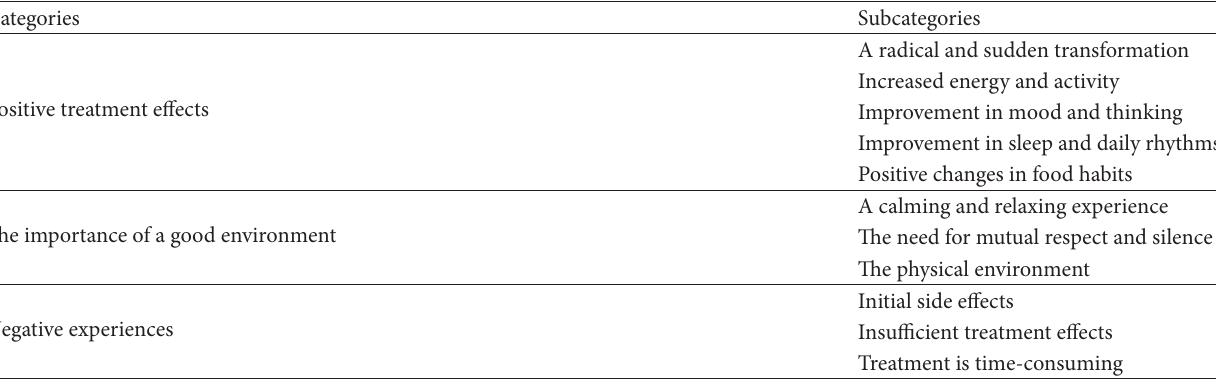
Table 3: Overview of the results regarding the patients’ experience of the light room treatment: three categories and 11 subcategories ( 𝑁 = 18 ).